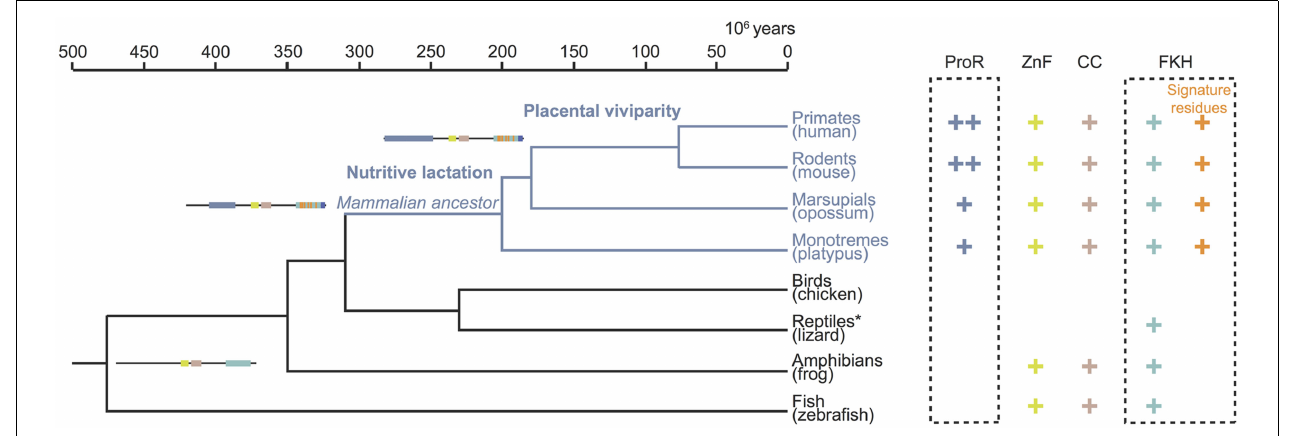
sign.Within the FKH the presence of Foxp3-specific signature residues is distinguished.The incremental gain of functional domains and signature residues is schematically represented. *The protein data available for lizard ( Anolis carolinensis ) is restricted to part of the